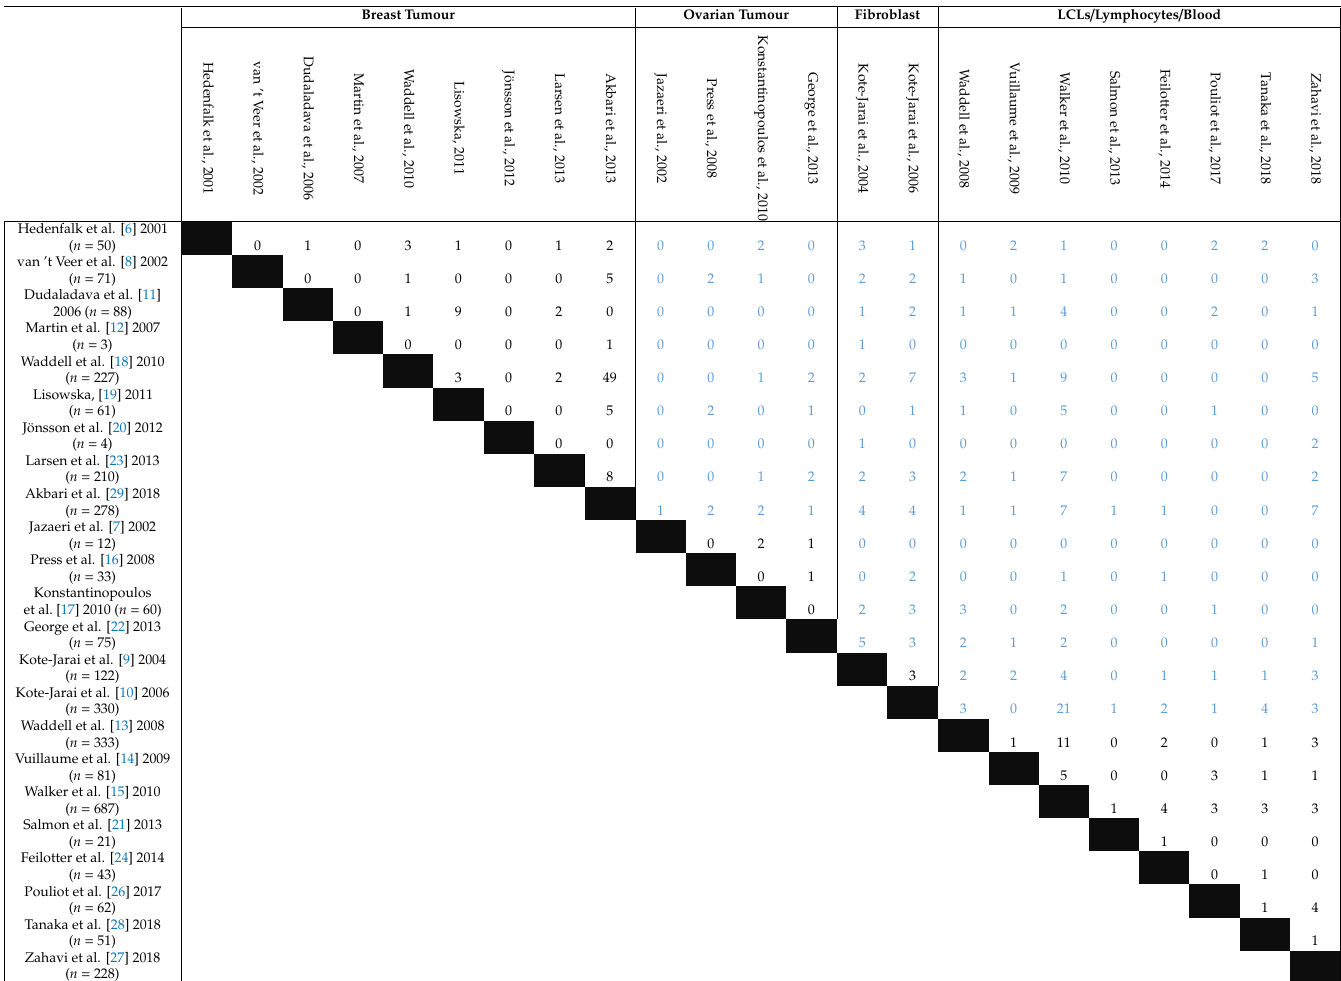
Black text, between tissue comparison; blue text across tissue comparison; ( n = The number of unique gene